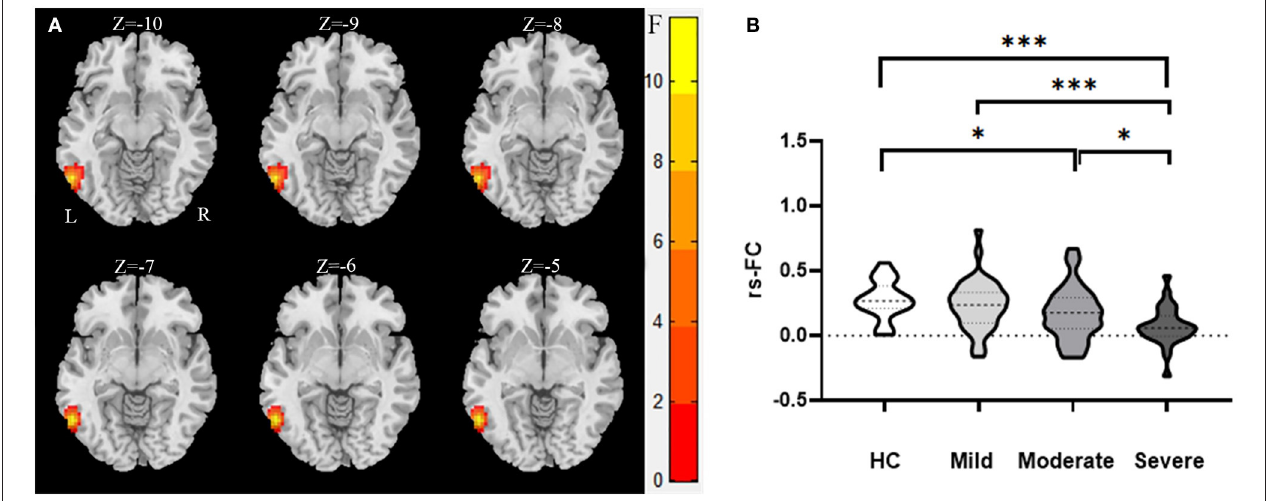
FIGURE 2 | The abnormal functional connectivity between the right inferior frontal orbital gyrus and left inferior temporal gyrus of the WMHs in MNI space. (A) Significant abnormal functional connectivities were observed between the right inferior frontal orbital gyrus and left inferior temporal gyrus [ − 10, − 9, − 8, − 7, − 6, − 5 in (A) are the coordinates of Z-axis in Montreal Neurological Institute space, and the unit of coordinate system is millimeter]. (B) Mean values of the abnormal functional connectivities in these groups. ***Significant at 0.001 level and *significant at 0.05 level (2-tailed).